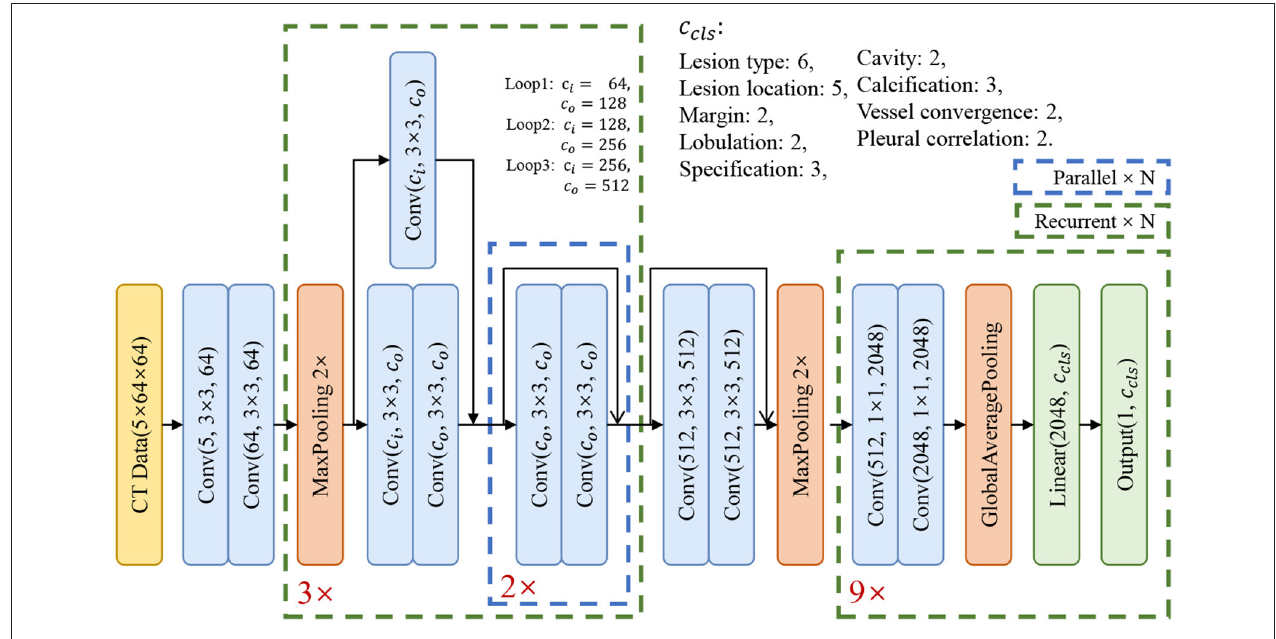
FIGURE 3 | The structure of our basic classification model.